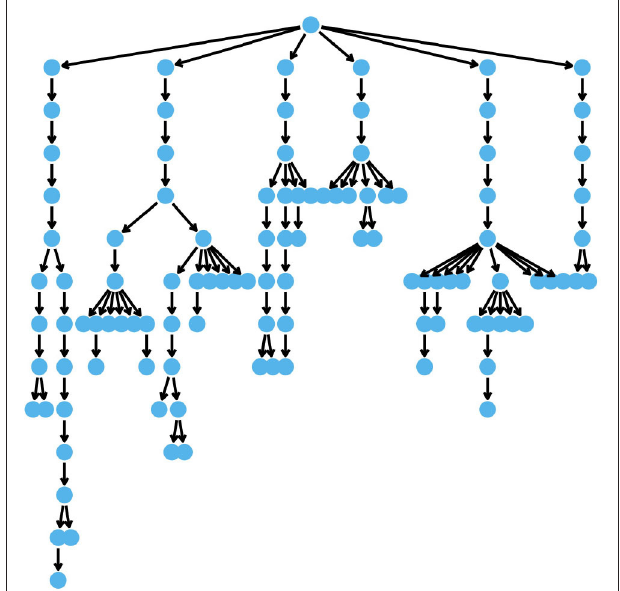
FIGURE 2 | The DAG describing the phylogeny of simulated haplotypes.